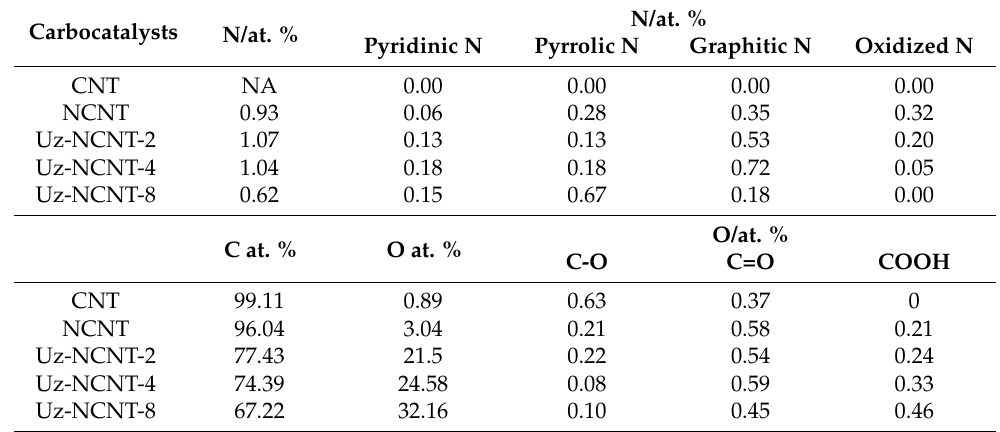
Table 1. Atomic percentages of elements in the carbocatalysts were obtained from XPS analysis. N/at. % Carbocatalysts N/at. % Pyridinic N Pyrrolic N Graphitic N Oxidized N CNT NA 0.00